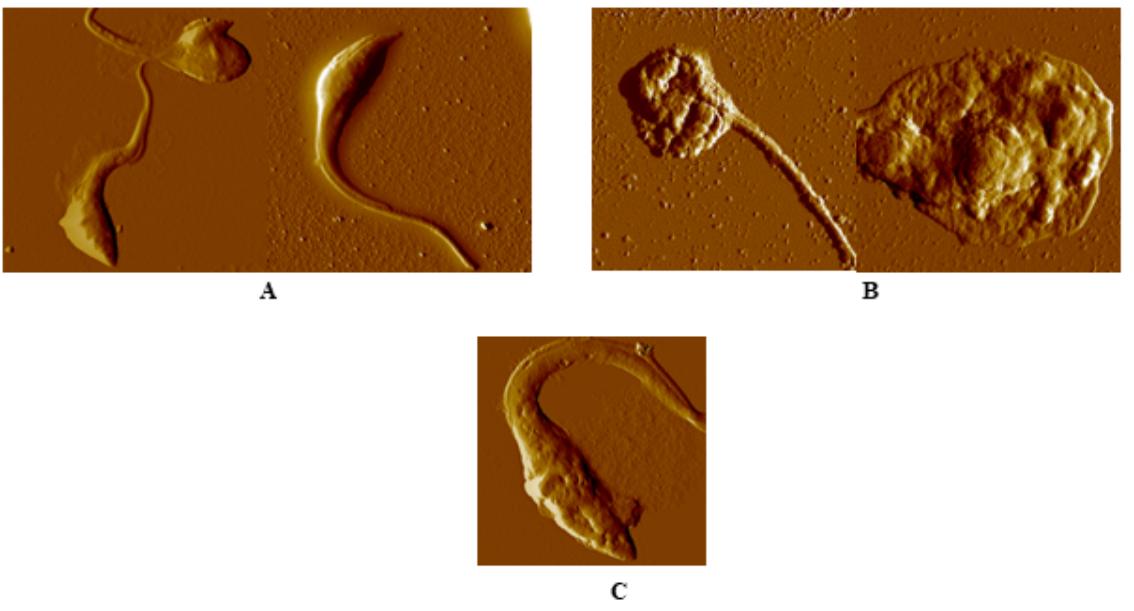
Figure 3. AFM amplitude images obtained at a 20 μm 2 scan size, of: (A) untreated T. cruzi epimastigotes; (B) T. cruzi epimastigotes after 72 h of treatment with PG 3, 1.26 µM; (C) T. cruzi epimastigotes after 72 h of treatment with benznidazole, 48